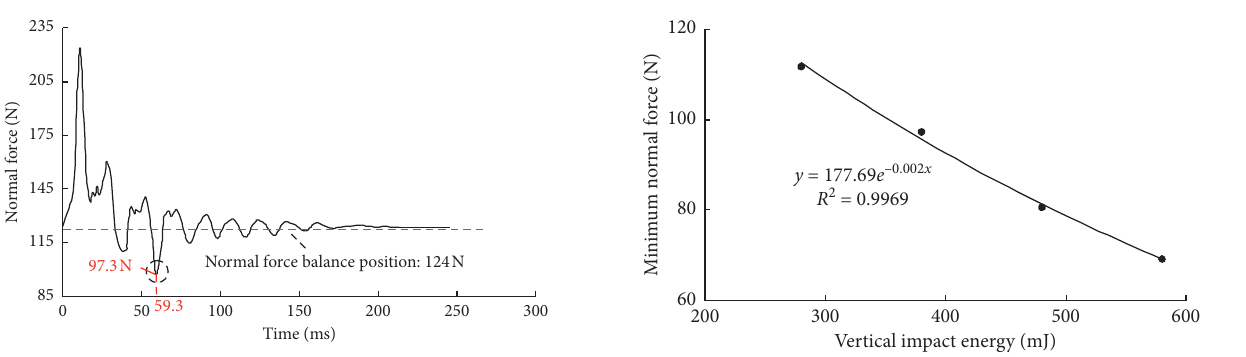
Figure 9: Relation curve between the vertical impact energy and the minimum normal force on the contact